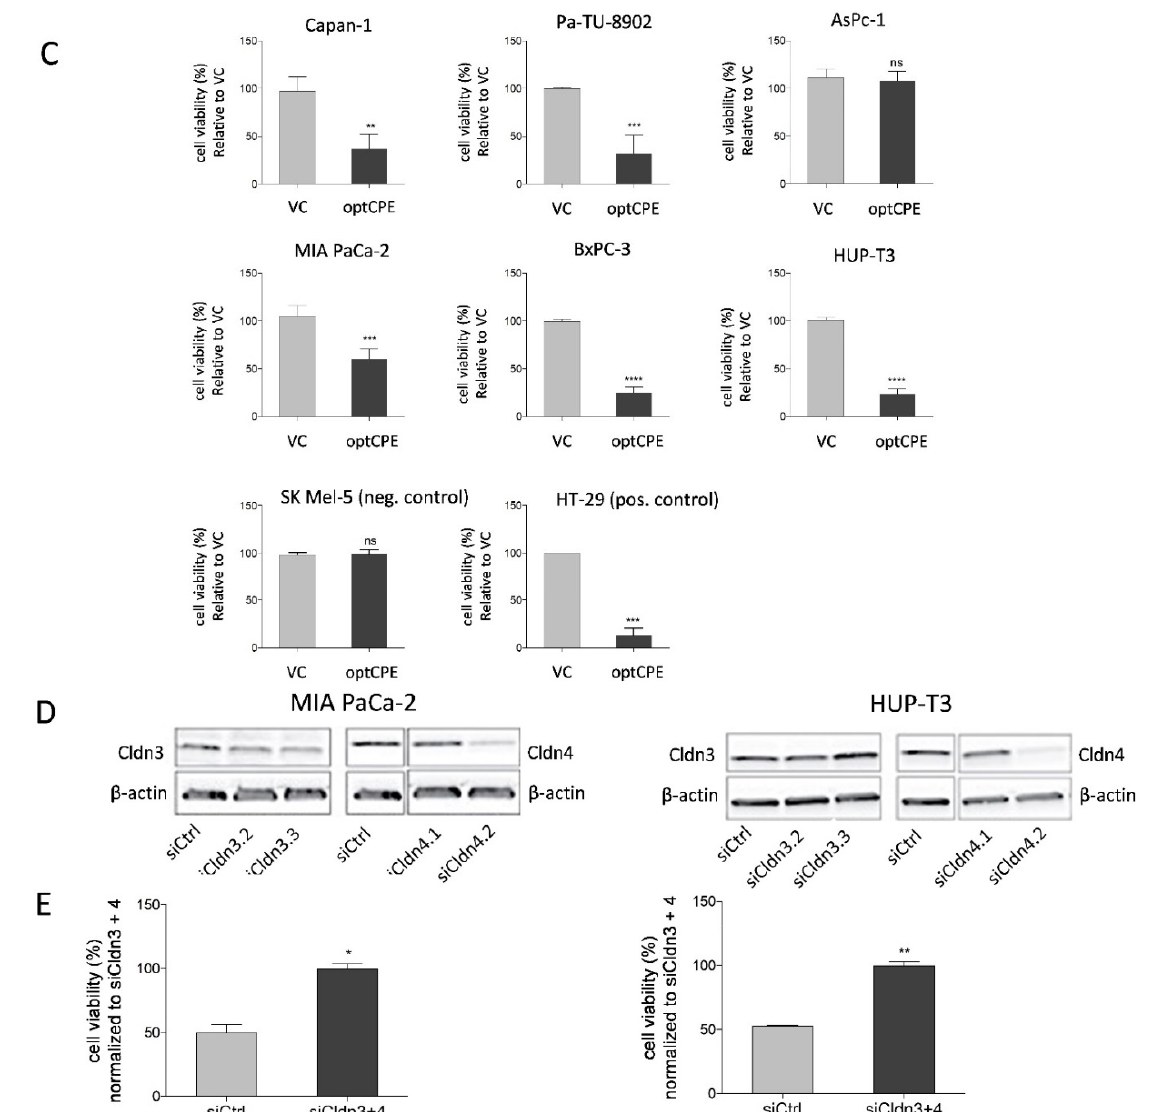
Figure 2. Expression of optCPE and selective cytotoxicity after in vitro gene transfer. ( A ) Representative immunofluores- cence images showing expression of optCPE (green) 12 h after transfection in Capan-1, HUP-T3 and PA-TU-8902 cells (40-fold magnification). Cytoplasm was stained with phalloidin (red) and nuclei with DAPI (blue). The images reveal strong CPE expression, with vesicle-like cytoplasmic accumulation, localization on cell membrane and cell contact regions. ( B ) Kinetic of optCPE expression in Capan-1, HUP-T3, MIA PaCa-2 and PA-TU-8902 cells 24 to 72 h after transfection (Figure S6). ( C ) Cytotoxicity of optCPE and vector control (VC) gene transfer was analyzed by MTT assay 72 h after transfection. All transfected Cldn3/4 expressing cells showed significant optCPE toxicity. SK MEL-5 negative control cells remained unaffected, supporting selectivity of optCPE. Data are represented as mean values ± S.D. ( n = 6), expressed as mean percentage of VC treated cells. ( D ) Rescue experiment in MIA PaCa-2 and HUP-T3 cells transfected with a pool of two specific small interfering RNAs or respective control (siCtrl), leading to efficient knockdown of Cldn3/4 at protein level (Western blot, (Figure S6). ( E ) Cldn-silenced cells were transfected with optCPE. MTT assay was performed 72 h later showing significantly reduced CPE cytotoxicity in MIA PaCa-2 and HUP-T3 cells compared to siCtrl treated cells, demonstrating selectivity optCPE. Data are represented as mean values ± S.D. ( n = 2), expressed as mean percentage of siCldn3/4 treated cells. (ns: not significant; * p < 0.05; ** p < 0.01; *** p < 0.001; **** p < 0.0001). To further prove selectivity of CPE cell killing, RNAi experiments were performed for specific downregulation of Cldn3/4 expression. MIA PaCa-2 and HUP-T3 cells were transfected with a pool of siCldn3 and siCldn4 or siCtrl, respectively (Figure 2D).